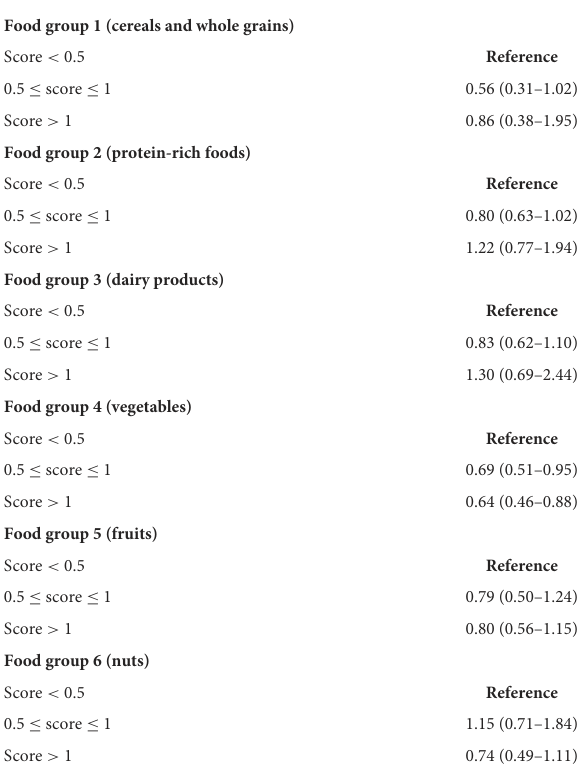
TABLE 3 Relationships between adherence to individual food group index recommendations and the presence of psychiatric morbidity. Variable n =